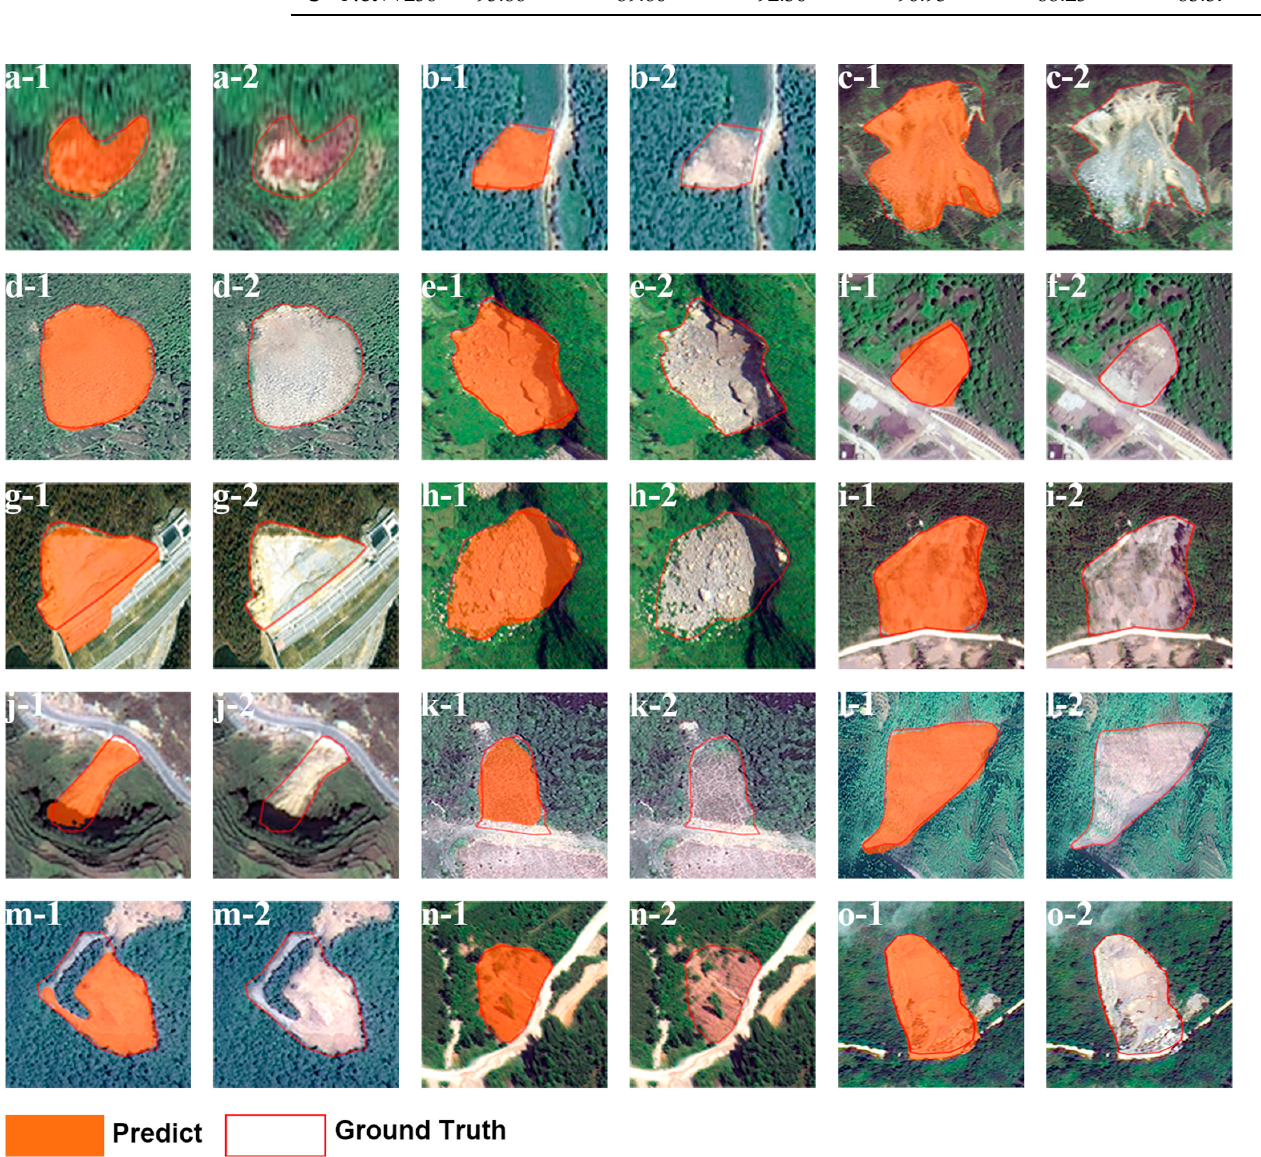
Figure 13. Prediction results. ( a1 – o1 ) The landslide detected by U − Net++256 (orange zone). ( a2 – o2 ) Ground truth (red